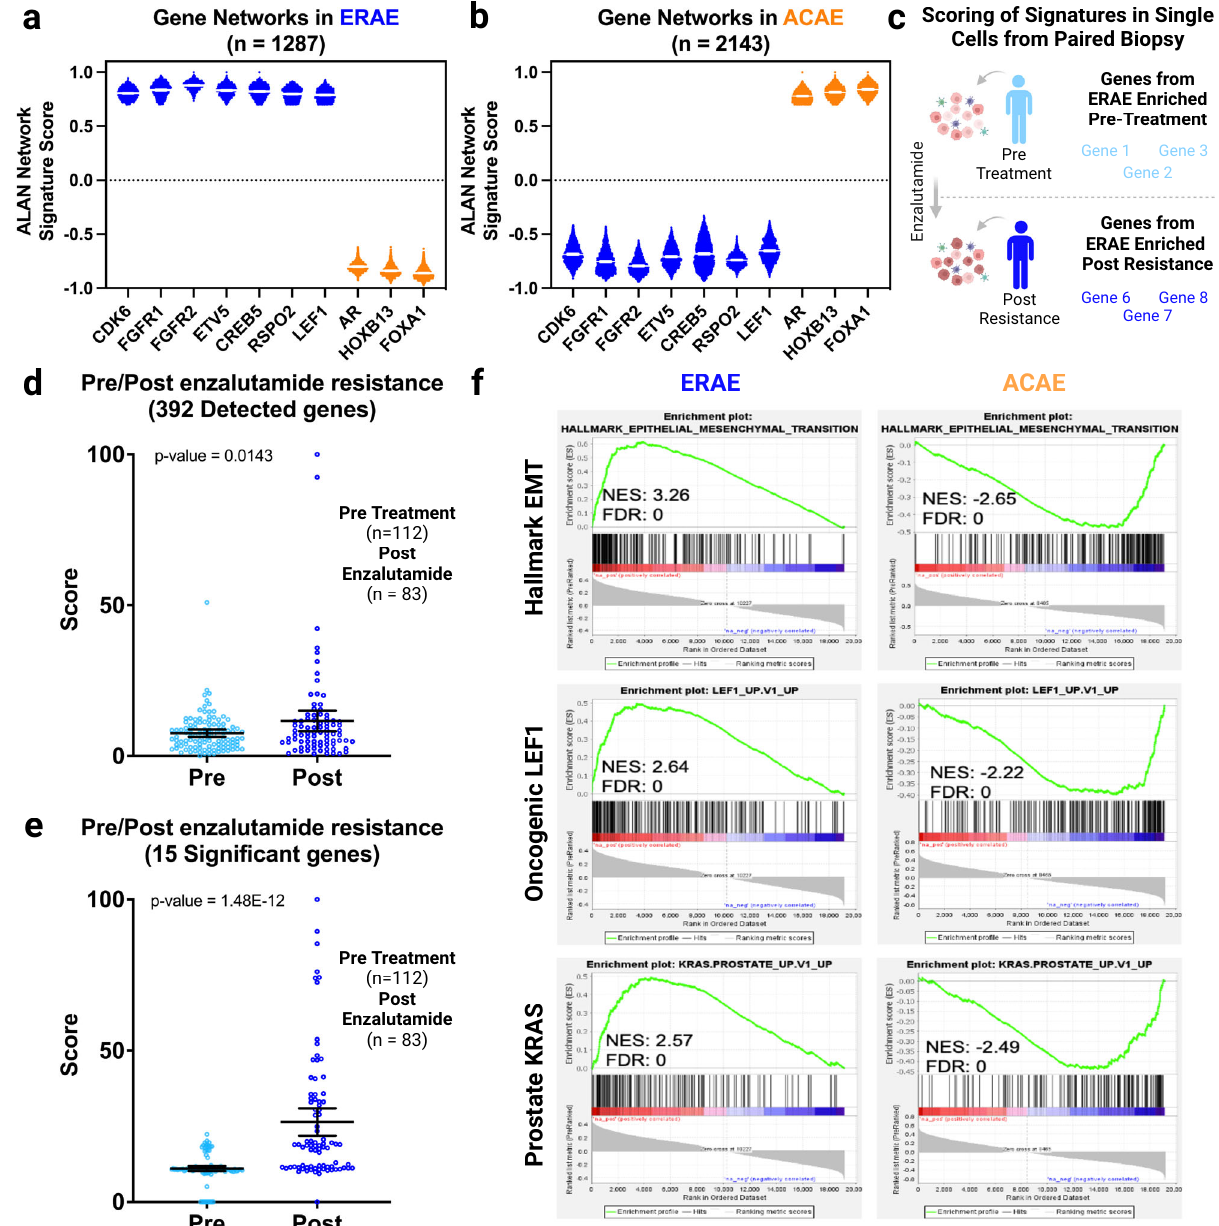
Fig. 4 ALAN identi fi es resistant gene signature distinct from AR and co-factors that is enriched post enzalutamide treatment and associated with resistant oncogenic signatures. a The ALAN pro fi le correlation value is plotted for each gene within the ERAE for the ALAN networks in blue ( CDK6 , FGFR1 , ETV5 , CREB5 , and LEF1 ) and orange ( AR , HOXB13 , and FOXA1 ). b The ALAN pro fi le correlation value is plotted for each gene within the ACAE for the ALAN networks in blue ( CDK6 , FGFR1 , ETV5 , CREB5 , and LEF1 ) and orange ( AR , HOXB13 , and FOXA1 ). For a and b , error bars represent mean with 95% con fi dence interval of the ALAN network signature score. c Work fl ow depiction of using a unique ALAN gene ecosystem signature for scoring cells from an individual patient with paired biopsies. d Scores are computed using the ERAE in all tumor cells that were pre-treatment ( n = 112) or post-Enzalutamide resistant ( n = 83) in one mCRPC patient. 392 of 1288 genes were detected in the scRNA-seq data. The statistical signi fi cance (p-value) was computed using a Student ’ s t-test. e Scores are depicted for all tumor cells from c using the 15 genes with the greatest expression increases in the postresistant samples. For d and e , error bars represent mean with 95% con fi dence interval of the ERAE score. f Aggregate ERAE and ACAE are analyzed and depicted through GSEA Enrichment Plots. Hallmark EMT, Oncogenic LEF1 and Prostate KRAS are shown with NES and FDR